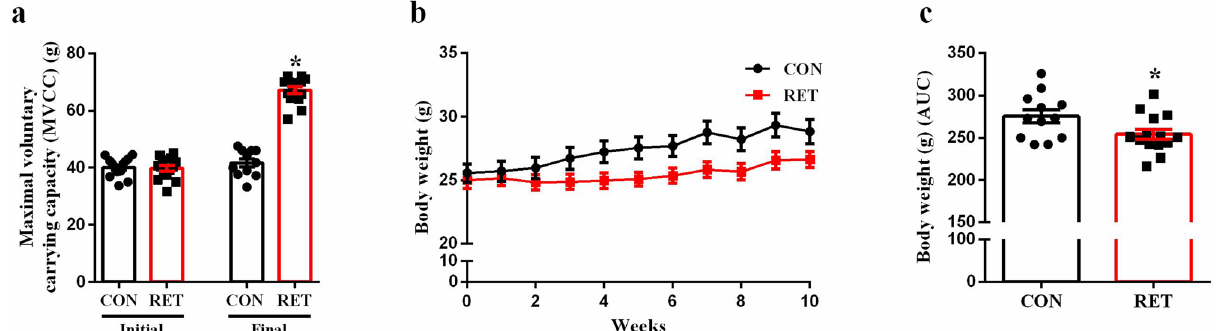
Figure 1. Resistance exercise increases maximal voluntary carrying capacity (MVCC) and reduces weight gain in trained mice. Initial and final maximal voluntary carrying capacity (MVCC) of CON (black bar, n = 12) and RET (red bar, n = 14) ( a ). Body weight over the course of 10 weeks ( b ) and its respective area under the curve (AUC) ( c ) of CON (black bar, n = 12) and RET (red bar, n = 14). Data are the mean ± SEM. *P ≤ 0.05 (Student’s t-test).